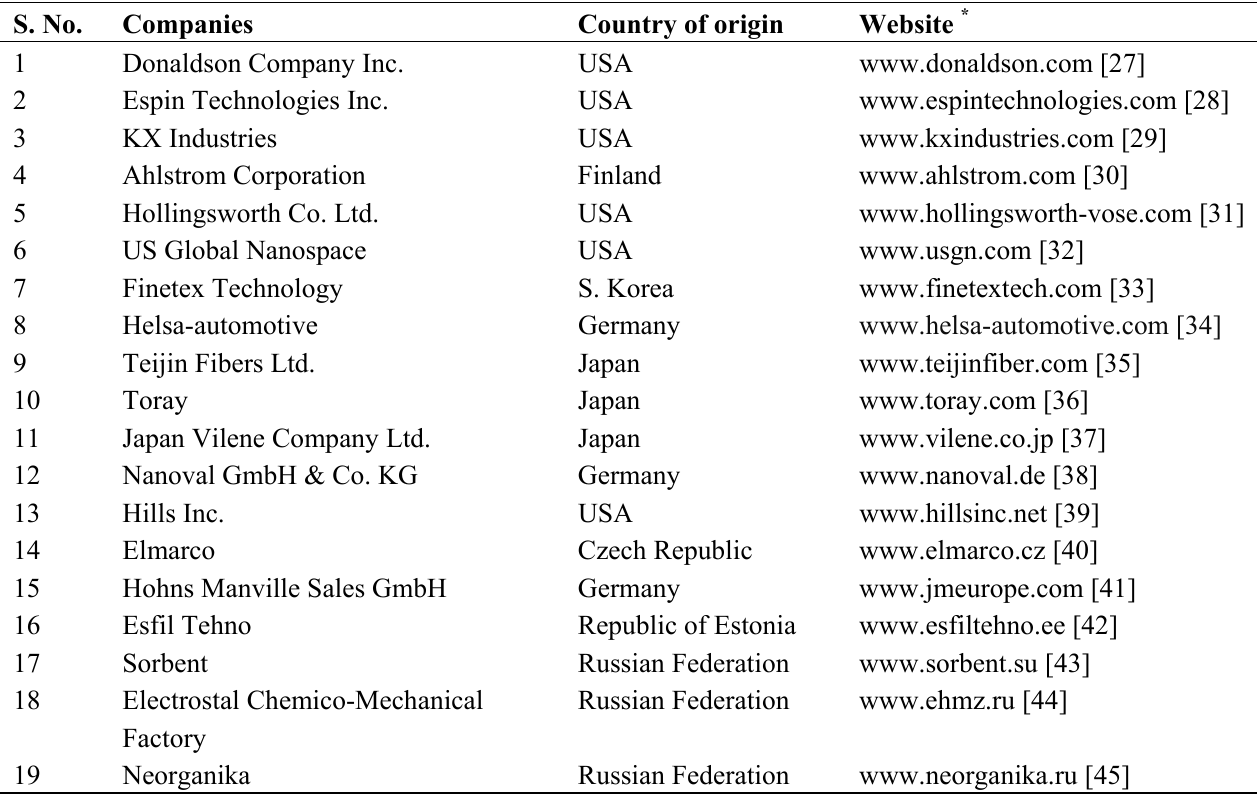
Table 1. Some of the Commercial suppliers of Nanofibers for Environmental Applications. S.